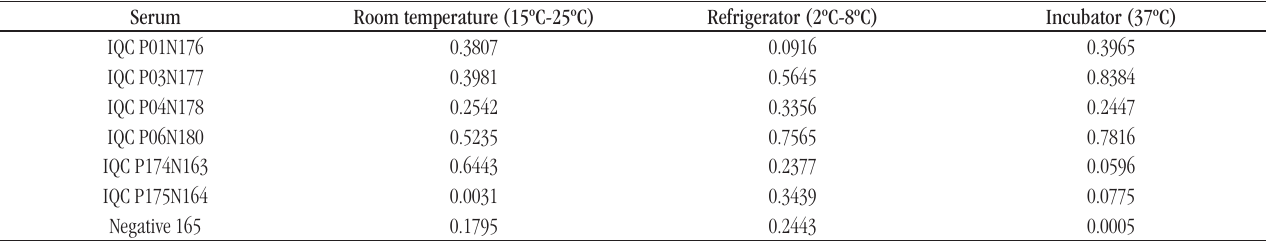
taBLE 2 − Results of the p -value, obtained by linear regression analysis, attributed to serum lots to verify stability in the different storage temperatures Serum